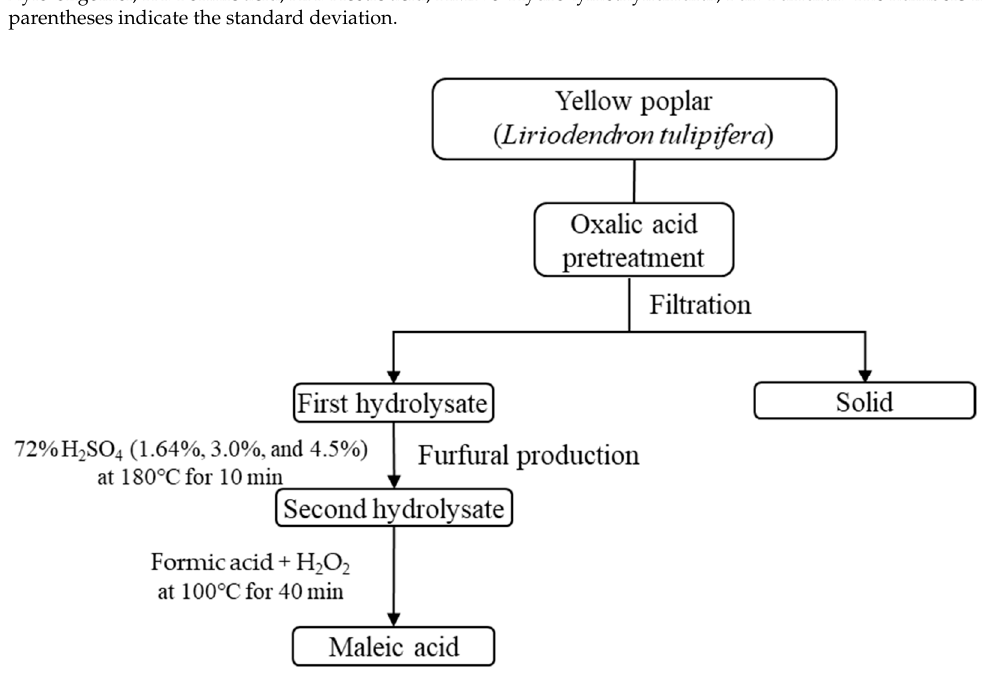
Figure 1. Maleic acid production from yellow